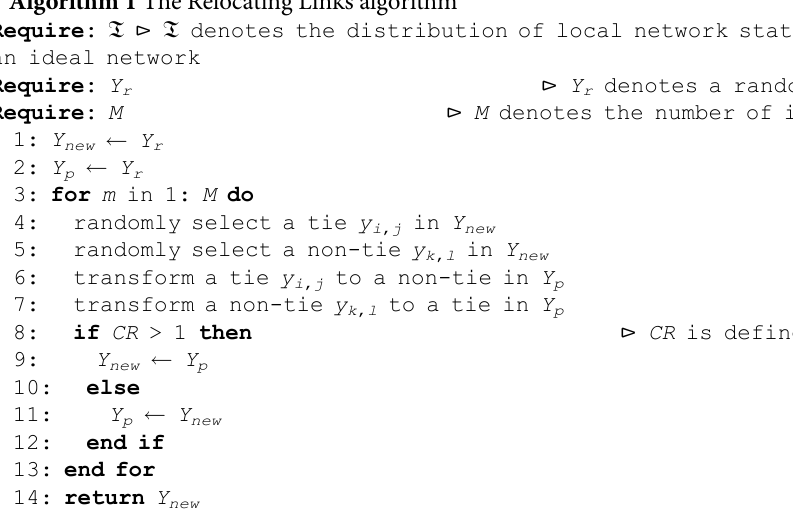
Algorithm 1 The Relocating Links